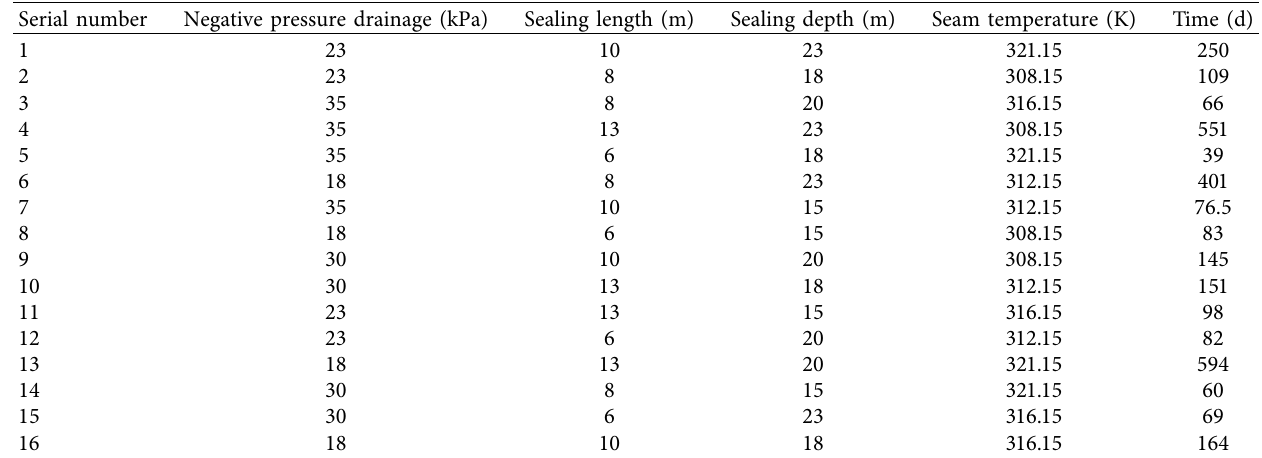
Table 2: Spontaneous combustion